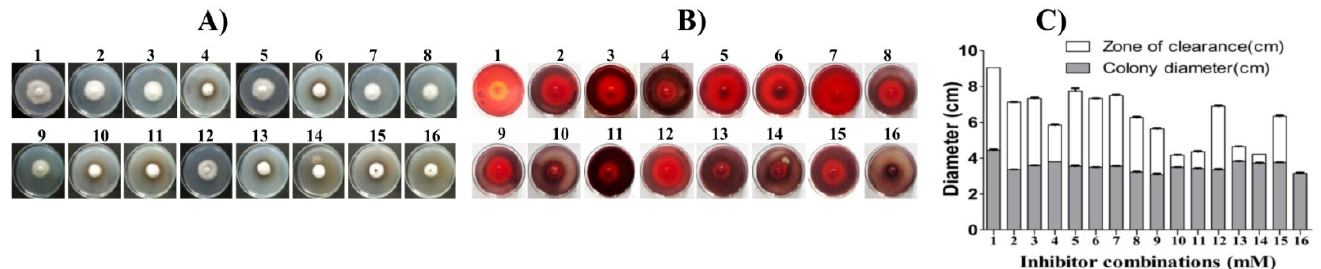
Figure 7. Effect of single and combined inhibitors (IC 50 ; mM) on endoglucanase activity of Colletotrichum sp. OH. ( A , B ) The mycelium growth and endoglucanase activity of OH and ( C ) bar graph showing colony diameter and zone of clearance on 1% CMC agar plate supplemented with different combinations of single and mixed inhibitors (combinations 1–16, Table 1) at their respective IC 50 concentrations (mM). Experiments were performed in triplicate, and the heights of the bars and the error bars indicate the means ± standard error mean (SEM).